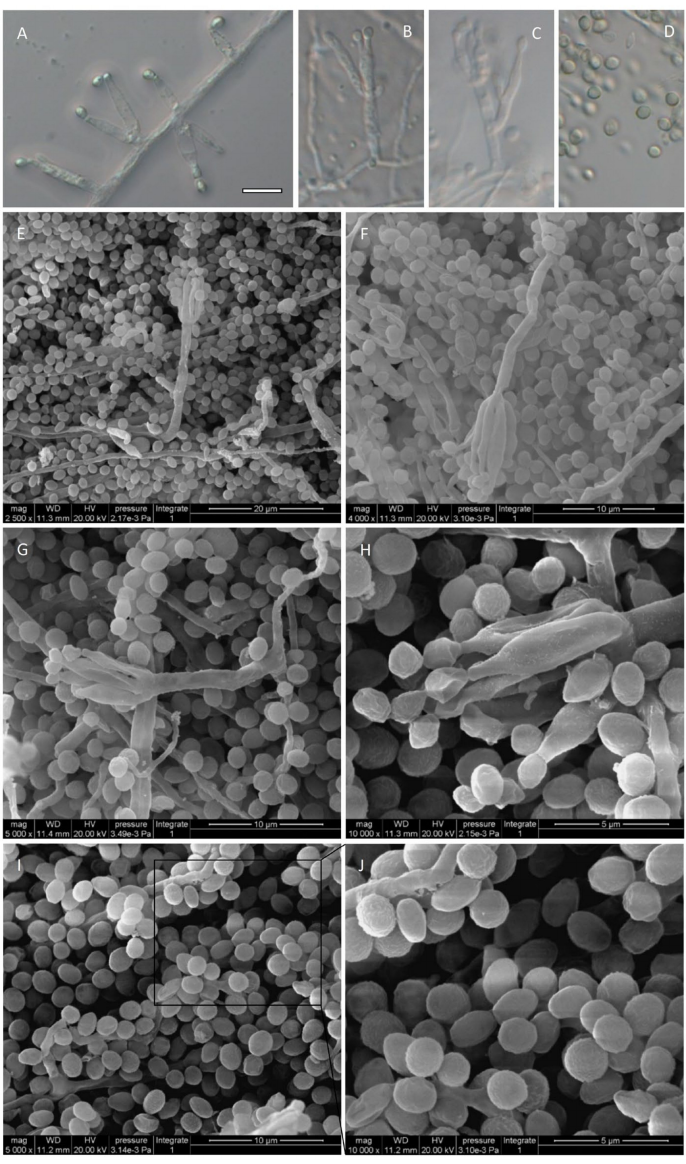
Figure 6. Micromorphological characters of JP-NJ4 (CCTCC M 2012167) (anamorphic stage) (inocula- tion for 1–2 wk on MEA). ( A – D ) Conidiophores and conidia, observed by optical microscope (Zeiss). ( A ) Reduced conidiophores consisting of solitary phialides. ( B ) Monoverticillate conidiophores. ( C ) Biverticillate conidiophores. ( D ) Conidia. ( E – J ) Conidiophores and conidia, observed by scanning electron microscope (SEM). ( E – G ) Conidiophores and conidia at different magnification (E. 2500 × ; F. 4000 × ; G. 5000 × ). ( H ) Phialides and conidia (10,000 × ). ( I – J ) Conidia. Scale bars: A = 10 µ m, applies to A–D. E = 20 µ m; F = 10 µ m; G = 10 µ m; H = 5 µ m; I = 10 µ m; J = 5 µ